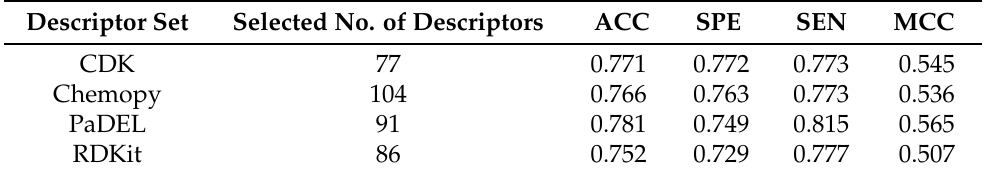
Table 2. The best performance of individual descriptor sets.